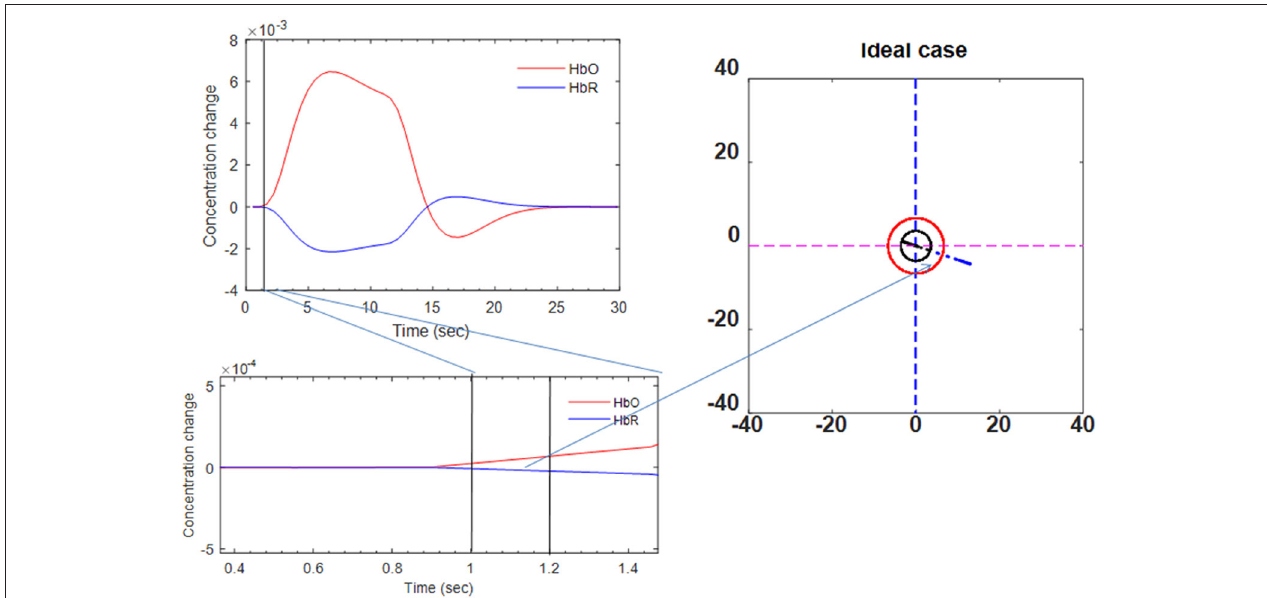
FIGURE 6 | Ideal trajectory of HbO/HbR made by two-gamma-function model (see Phases 7 and 8 in Table 2 ).